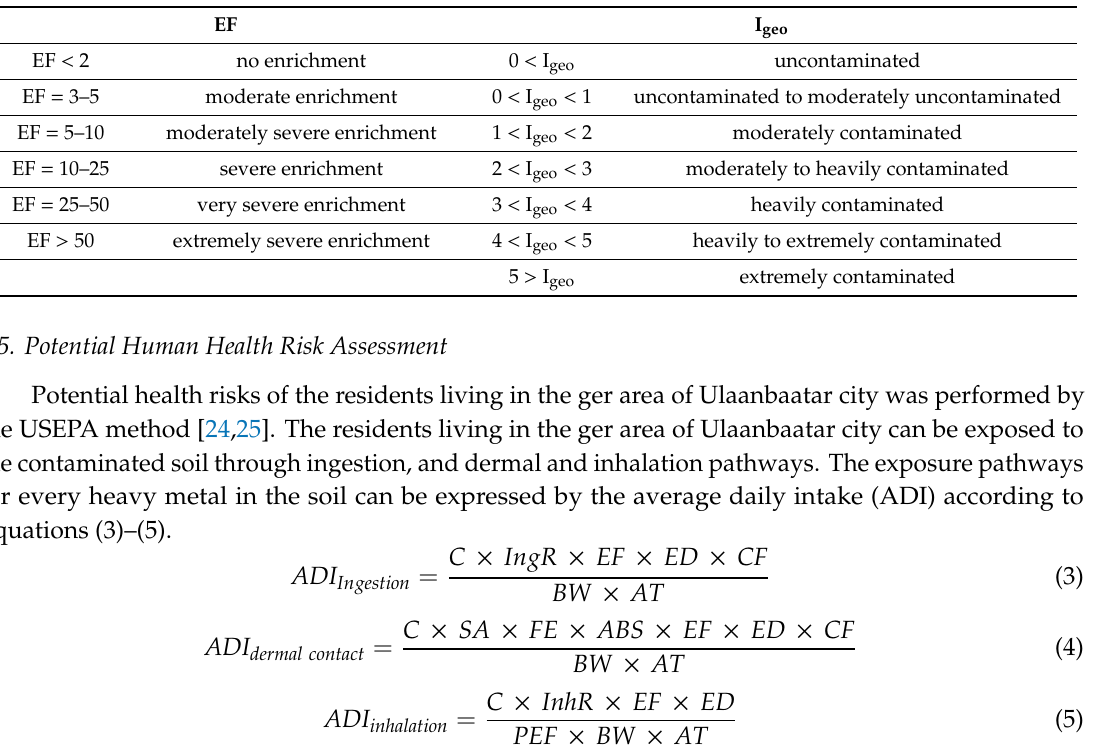
Table 2. Category of EF (enrichment factor) and I geo (geo-accumulation).